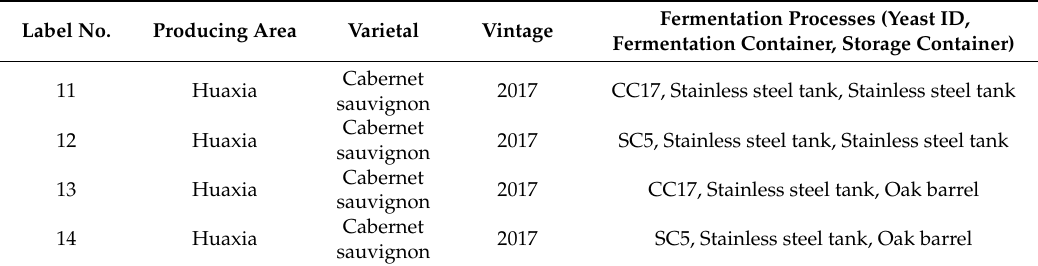
Table 5. Details of wine samples with different fermentation